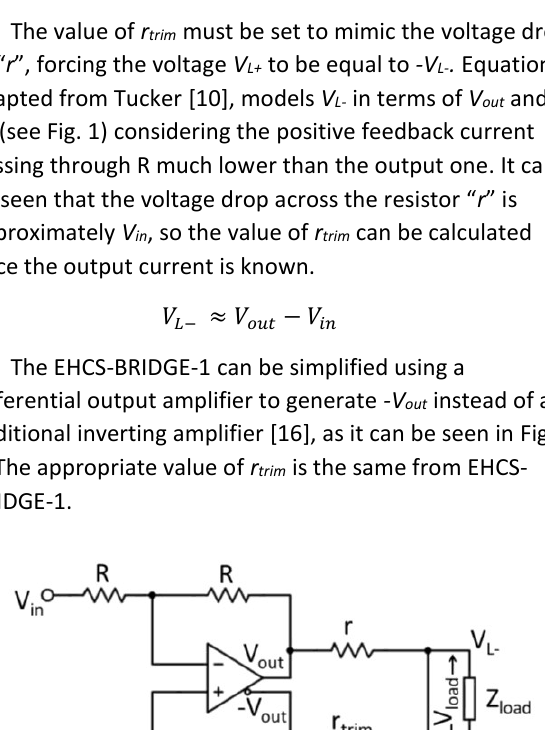
Fig.2: Enhanced Howland Current Source with Bridge topology (BRIDGE-1)